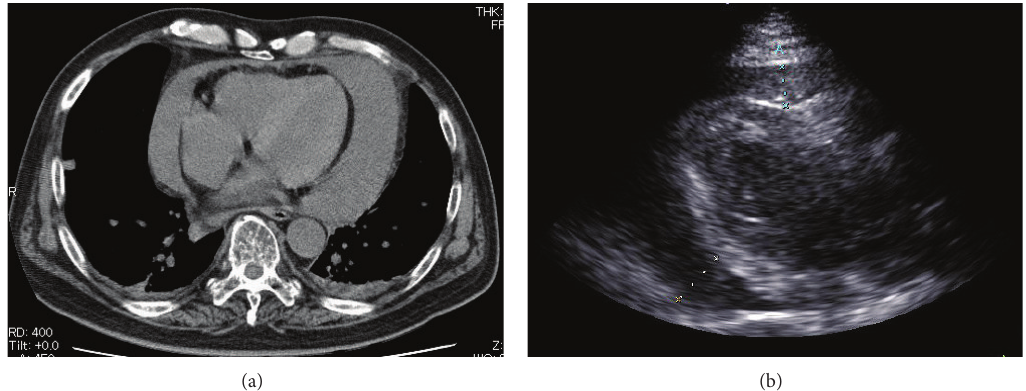
Figure 1: Chest CT scan showing large pericardial effusion (a) and echocardiogram showing circumferential pericardial effusion (b). 95.5%; total protein, 7.1 g/dL; glucose < 5 mg/dL; lactate